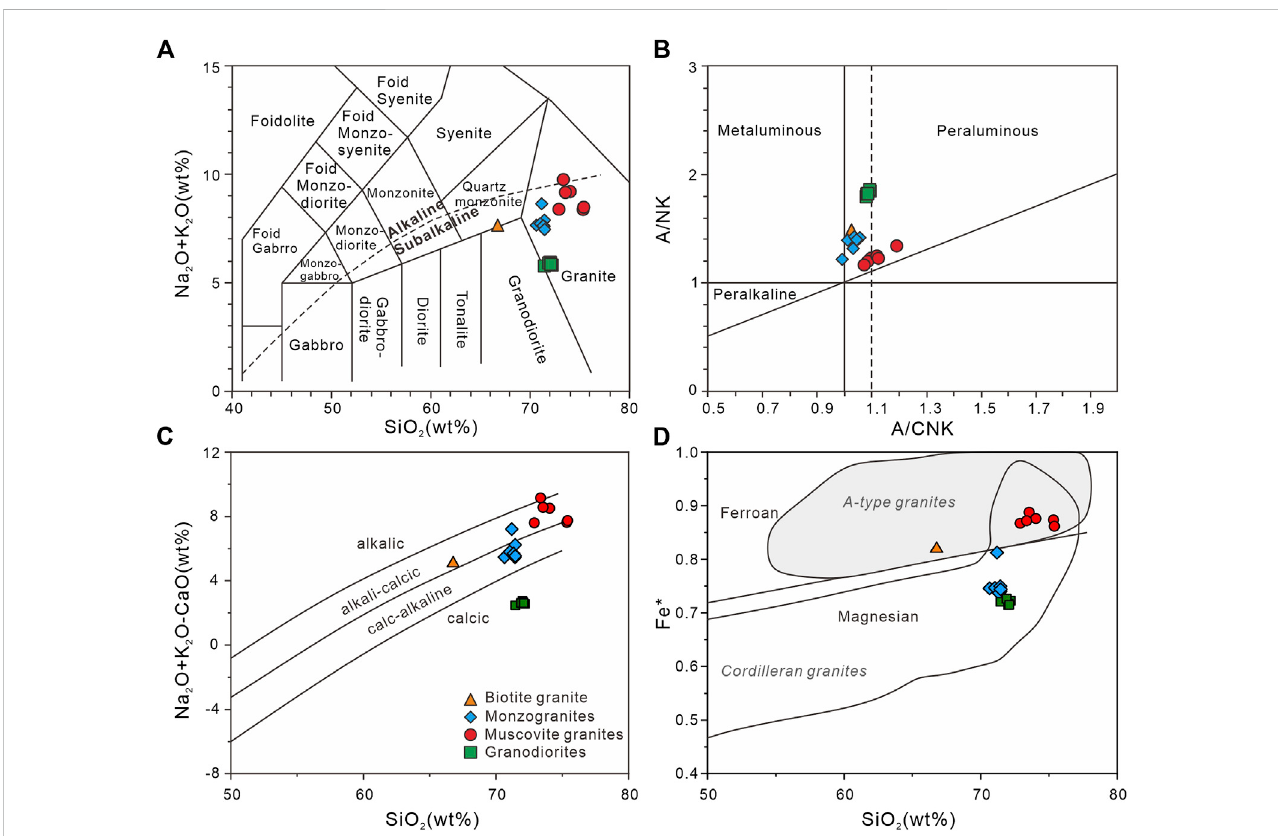
FIGURE 3 Geochemical classi fi cation diagrams using major element oxides. (A) (Na 2 O+K 2 O) vs . SiO 2 (Irvine and Baragar, 1971; Middlemost, 1994). (B) A/NK vs . A/ CNK (Maniar and Piccoli, 1989). A/CNK = molar Al 2 O 3 /(CaO+Na 2 O+K 2 O); A/NK = molar Al 2 O 3 /(Na 2 O+K 2 O). (C) (Na 2 O+K 2 O – CaO) vs . SiO 2 and (D) FeO* vs . SiO 2 (Frost et al., 2001). Fe*=FeO T /(FeO T